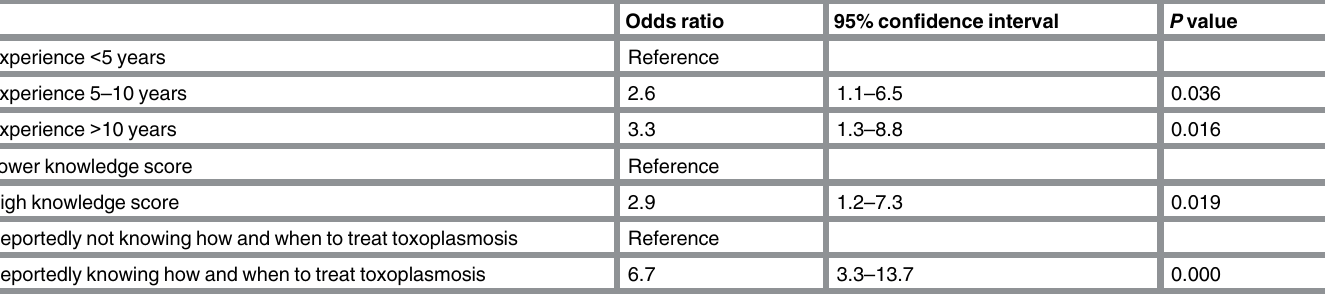
Table 3. Multivariable logistic regression model for predicting having seen a case of clinical toxoplasmosis among medical doctors in